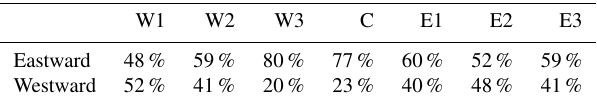
Table 2. Percentage of occurrence between the eastern ( u ) compo- nent of eastward and westward flows at the selected